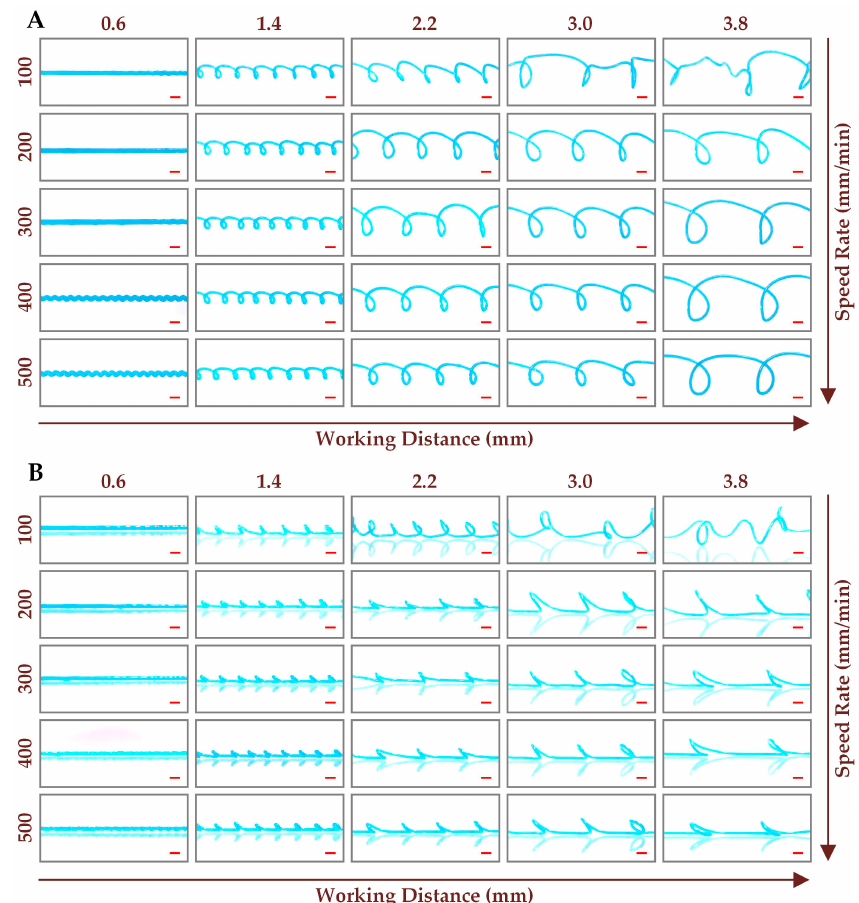
Figure 4. Optical photos of the printed channel molds at di ff erent working distances and printing speeds with the extrusion amount fixed at 0.144 mm 3 from vertical view ( A ) and side view ( B ). The red scale bar represents 1